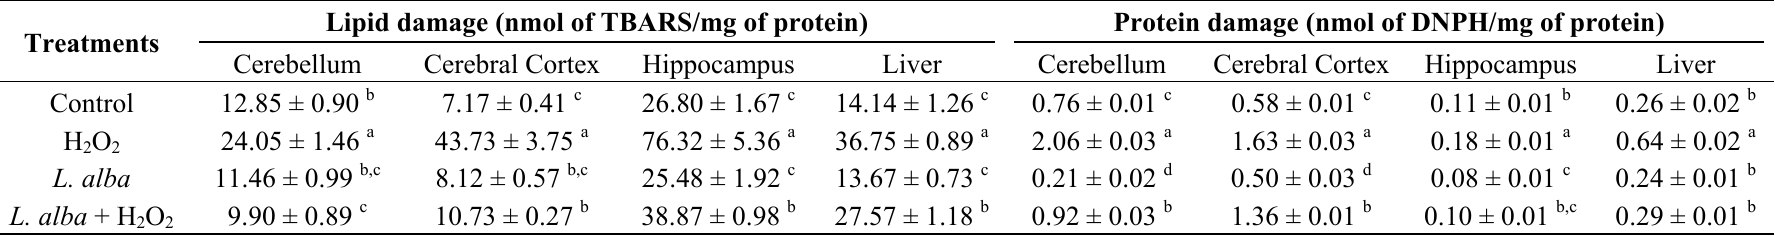
Table 5. Lipid and protein damage in rat cerebellum, cerebral cortex, hippocampus and liver cells treated with L. alba . Treatments